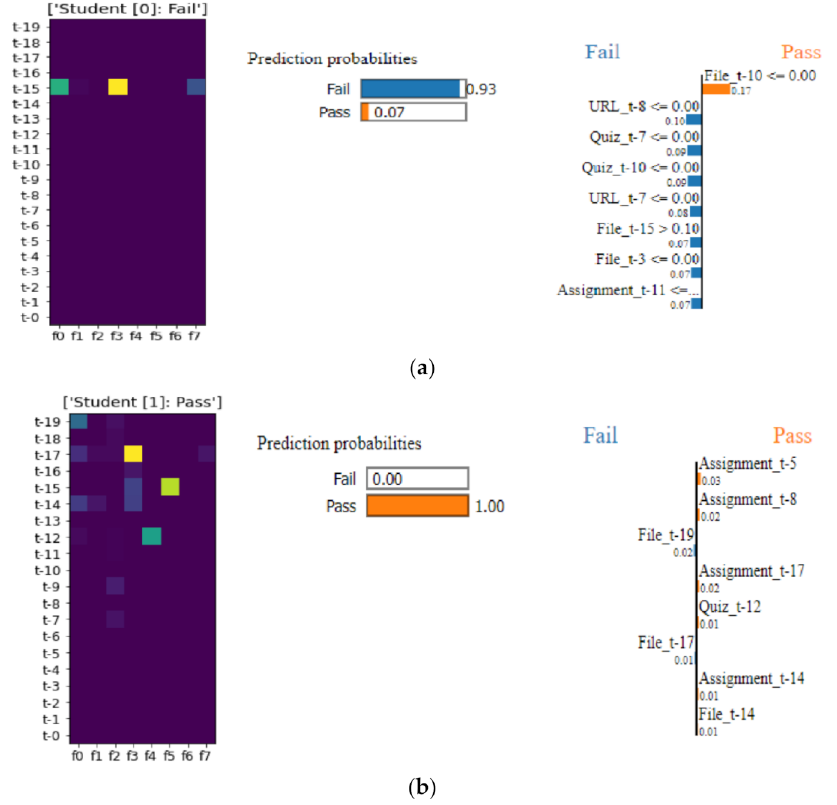
Figure 5. The visualized data set of two types of student performance with its interpretability: ( a ) ‘Fail’ and ( b )